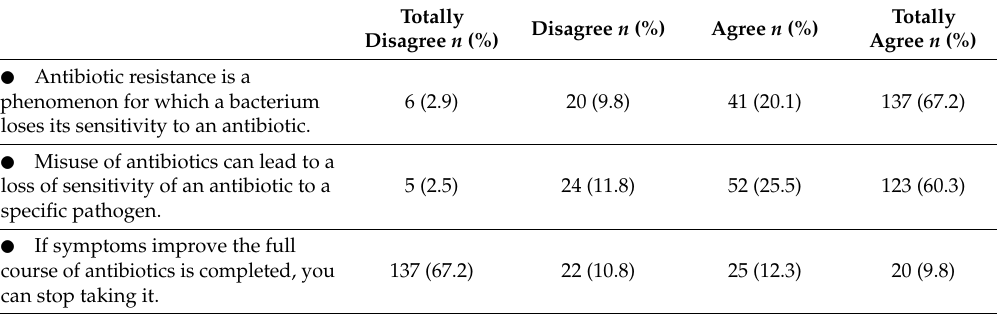
Table 3. Awareness of antibiotic resistance ( n = 204).